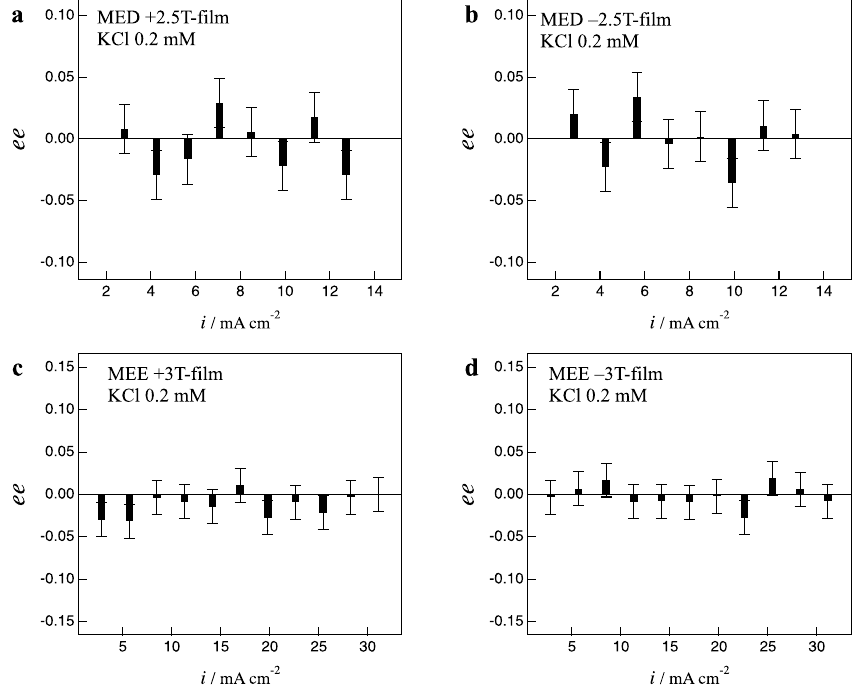
Figure 7. The ee ratio profiles of the MED and MEE films prepared with KCl additives. ( a ) MED +2.5T-film, ( b ) MEE −2.5T-film, ( c ) MEE +3T-film and ( d ) MEE −3T-film.